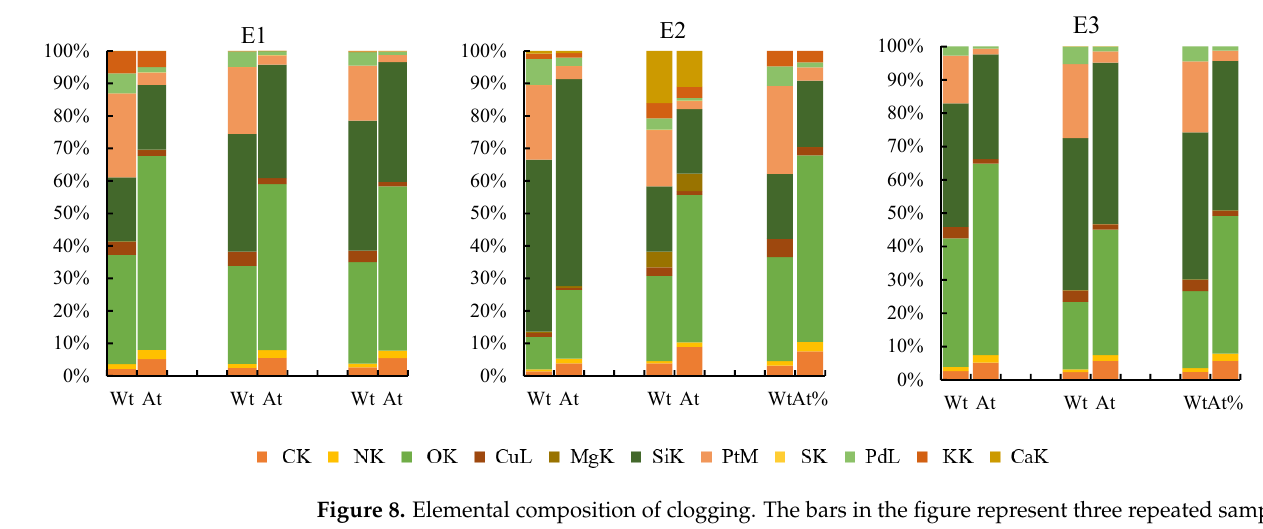
Figure 8. Elemental composition of clogging. The bars in the figure represent three repeated samples. Wt (%) is the mass ratio of each element, and At (%) is the atomic ratio of each element.